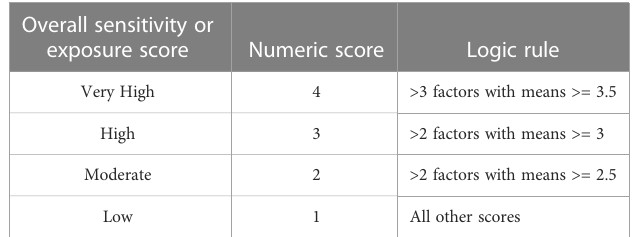
TABLE 4 Logic rule for calculating overall species ’ climate exposure and biological sensitivity. Overall sensitivity or exposure